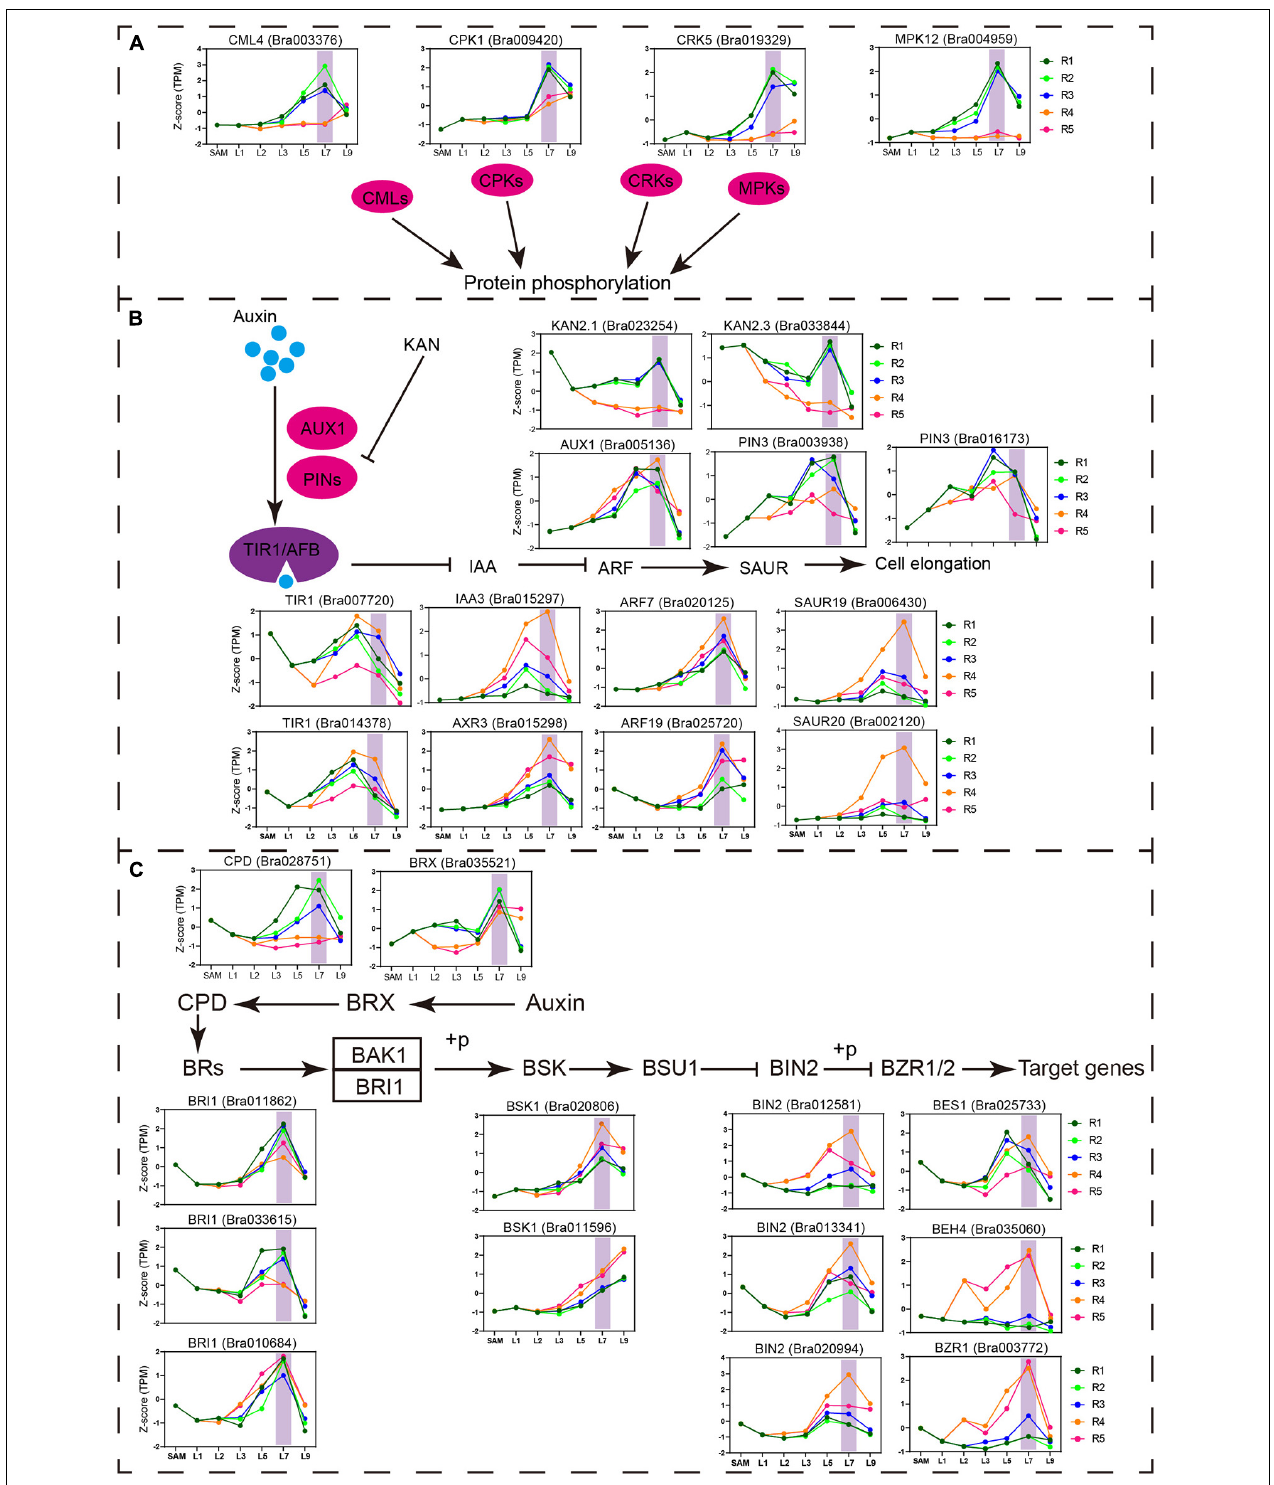
FIGURE 7 | Important pathway identified in the key transition leaves. (A) Expression profiles of the genes related to protein phosphorylation and calcium ion binding identified in key transition leaves. Vertical shade boxes indicate transition leaves position. (B) Expression profiles of auxin signaling genes upregulated in key transition leaves. Vertical shade boxes indicate transition leaves position. (C) Expression profiles of BR signaling genes upregulated in key transition leaves. Vertical shade boxes indicate transition leaves position.